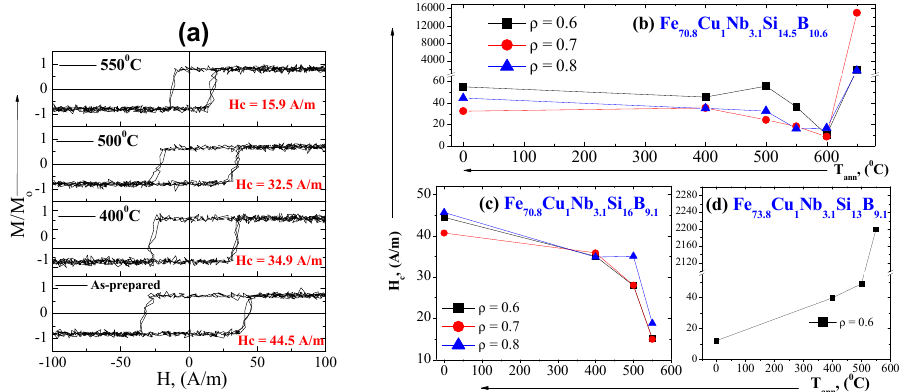
Figure 7. Hysteresis loops of as-prepared and annealed Fe 70.8 Cu 1 Nb 3.1 Si 14.5 B 10.6 microwire at T ann ranging between 400 and 600 °C ( a ); coercivity dependence on T ann of Fe 70.8 Cu 1 Nb 3.1 Si 14.5 B 10.6 for different ρ -ratios ( b ); H c dependence on T ann of Fe 70.8 Cu 1 Nb 3.1 Si 16 B 9.1 microwires for different ρ -ratios ( c ); and of Fe 73.8 Cu 1 Nb 3.1 Si 13 B 9.1 for ρ -ratio = 0.6 ( d ). Reproduced from reference [47], Figure 4.